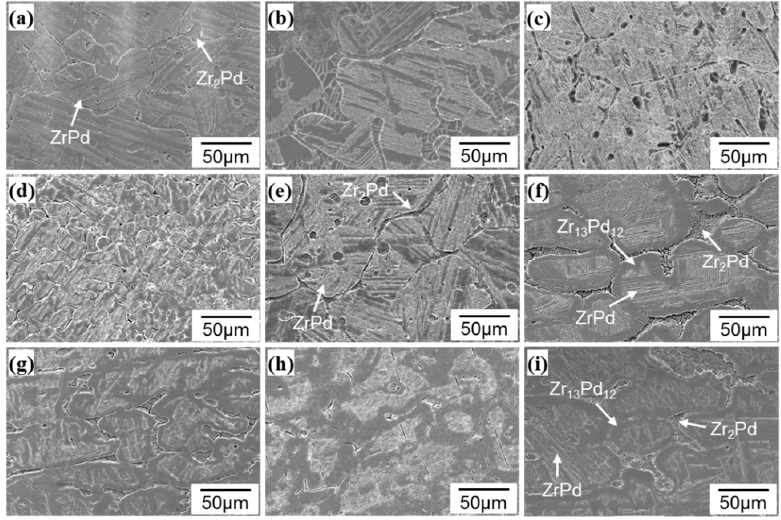
Figure 10. SEM images of Zr-48.0 atom % Pd alloy: ( a ) solution treated and quenched from 1273 K; aged at each temperature for 720 ks. ( b ) 1123 K, ( c ) 1113 K, ( d ) 1108 K, ( e ) 1103 K, ( f ) 1098 K, ( g ) 1093 K, ( h ) 1088 K, and ( i ) 1083 K, respectively.